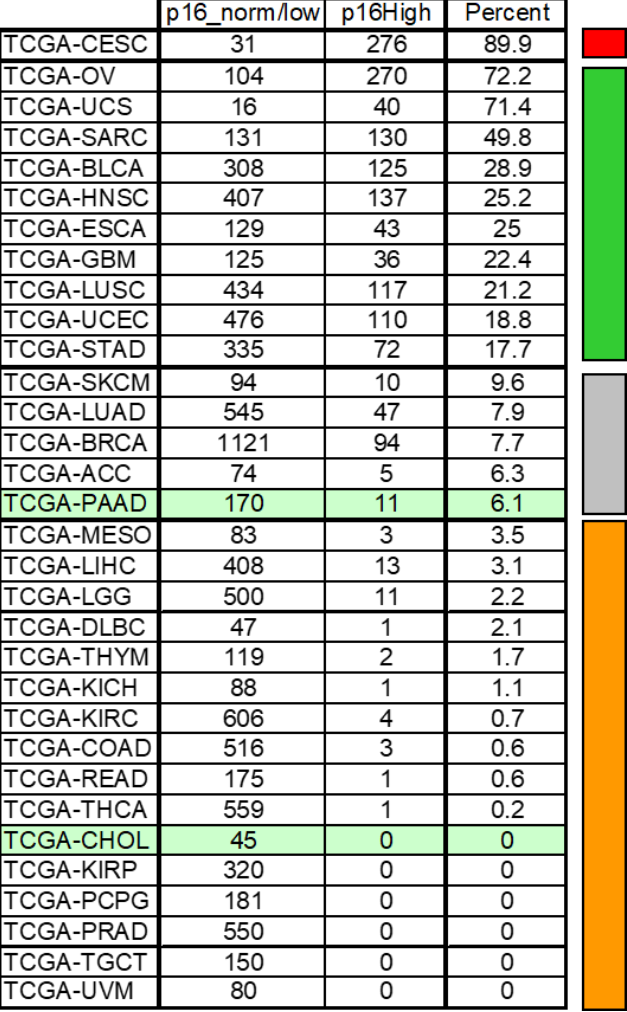
Figure 7. Proportion of tumors with an elevated CDKN2A level (TCGA database). The tumor types analyzed in the TCGA study are indicated in the first column. The numbers of tumors of each study with a low or normal CDKN2A expression is indicated in the second column. The numbers of tu- mors with elevated CDKN2A expression (comparable to the expression reached in HPV+ tumors) are indicated in the third column. The proportion with respect to the total of tumors with elevated CDKN2A is indicated in the forth column ("Percent") for each study. Tumors of the pancreas or cholangiocarcinoma are highlighted in green. The color code on the right indicates whether a pre- dictive test would be needed to select responsive patients. In red, a test is unlikely to be useful be- cause almost 90% of the tumors have elevated CDKN2A and likely lacks phosphorylated CDK4.